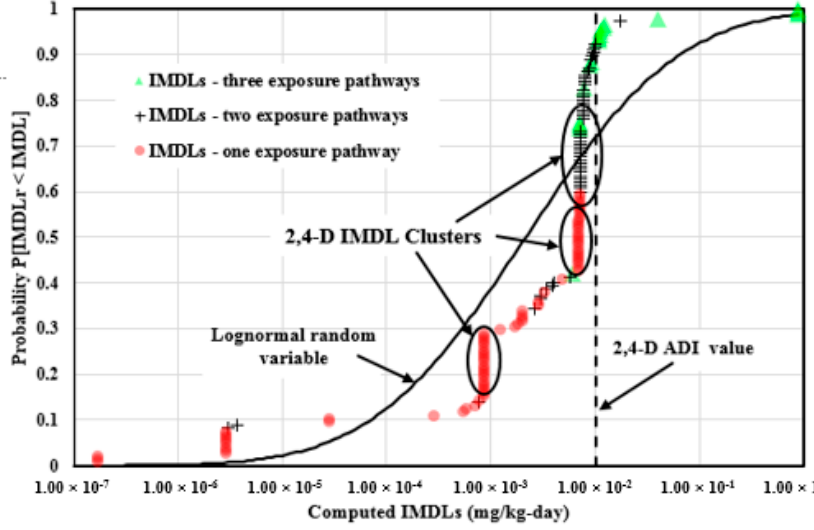
Figure 8. 2,4-D implied maximum dose limits (IMDLs) computed from soil, drinking water, and the commonly consumed agricultural commodities plotted in the empirical cumulative distribution form and compared to the log-normal random variable cumulative distribution with identical statistics.